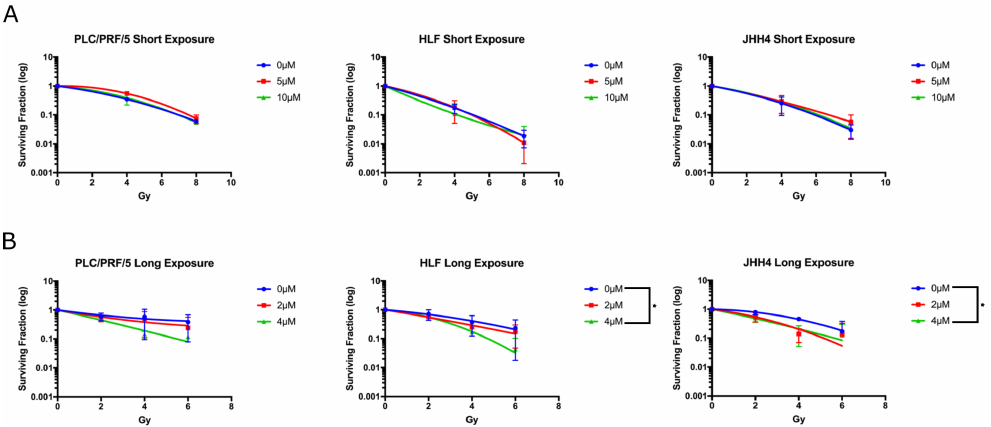
Figure 3. Clonogenic assays measuring sensitizing effect of vandetanib in conjunction with ionising radiation. Following treatment, response to vandetanib was observed consistently across all cell lines. ( A ) When cells were administered vandetanib at high dose (5–10 µ M) for short duration (24 h), no radiosensitisation was measured. ( B ) Cells receiving a lower dose (2–4 µ M) for longer exposure (72 h) showed enhancement of radiation-induced cell death. Cells treated with 5 or 10 µ M vandetanib were eradicated after long exposure and were not included in the study. * RER exceeds 95% CI, ANOVA p ≤ 0.05.